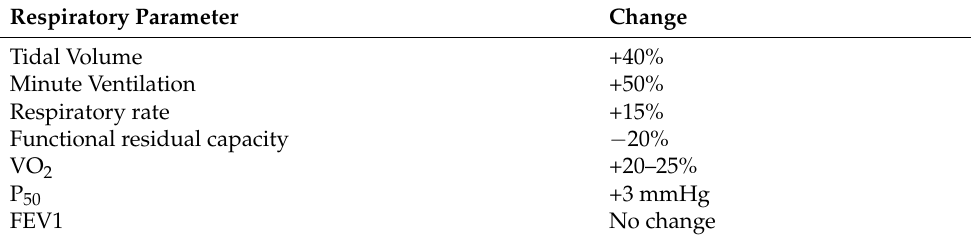
Table 3. Respiratory changes during